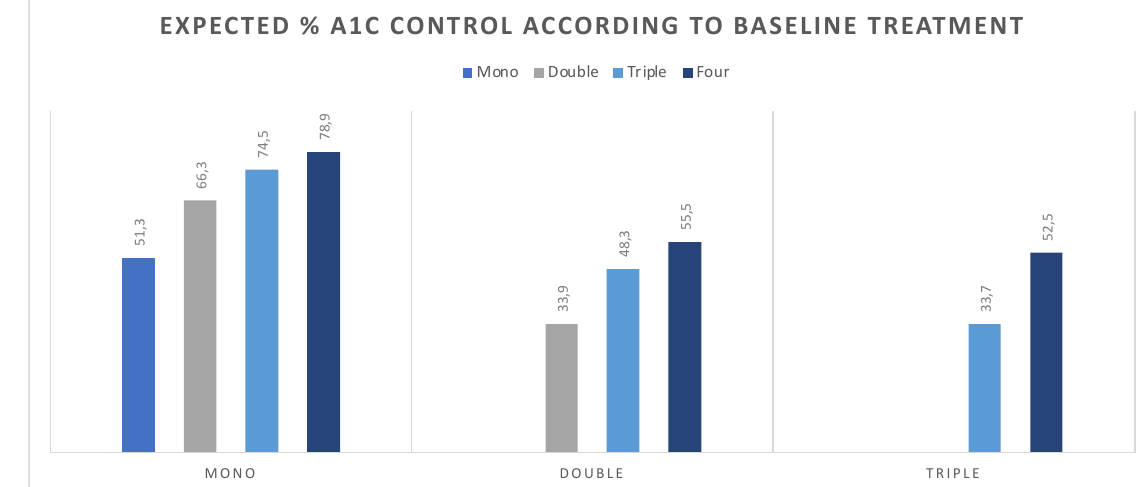
Figure 5. Baseline and expected % change in A1c control according to current therapy and estimated mean reduction in A1c with intervention.